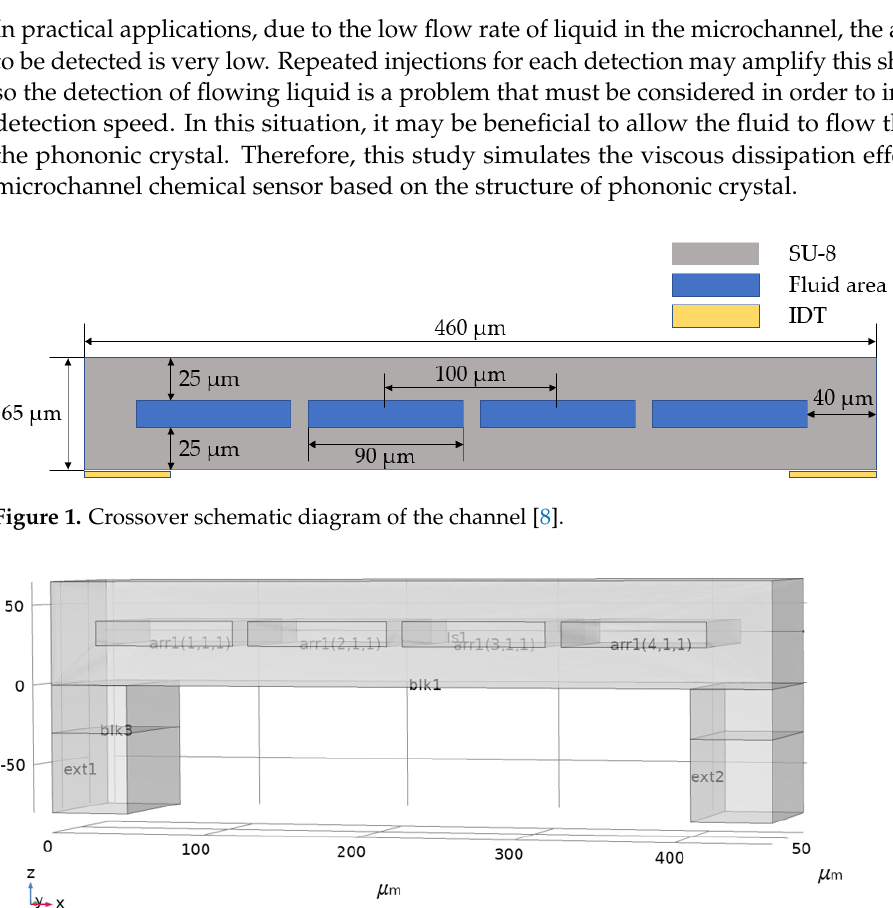
Table 1. Physical parameters of SU-8 (Young’s modulus and Poisson’s ratio are cubic polynomially fitted using the data in reference [10] (the SU-8 in this reference is not post-baked, so the Young’s modulus is relatively low)).